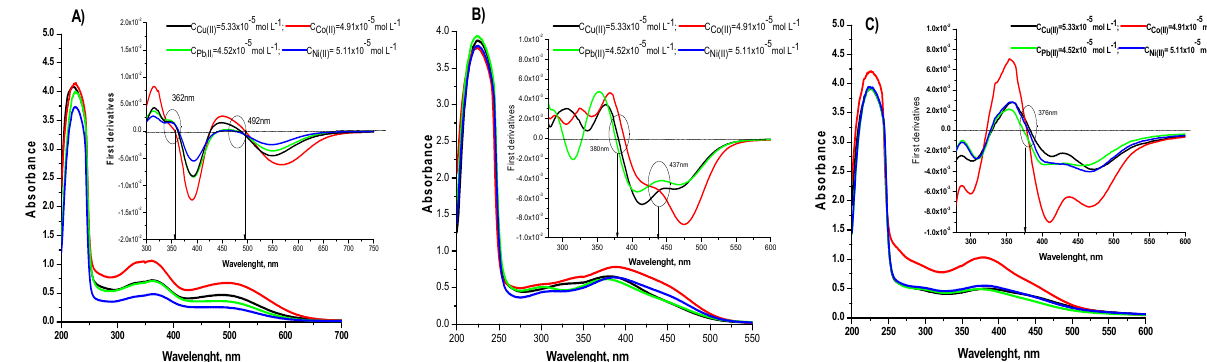
Scheme 1. Coordination of the metal ions (Cu(II), Ni(II), Co(II), Pb(II)) in complexation with N-phthalimide azo-azomethine derivative.